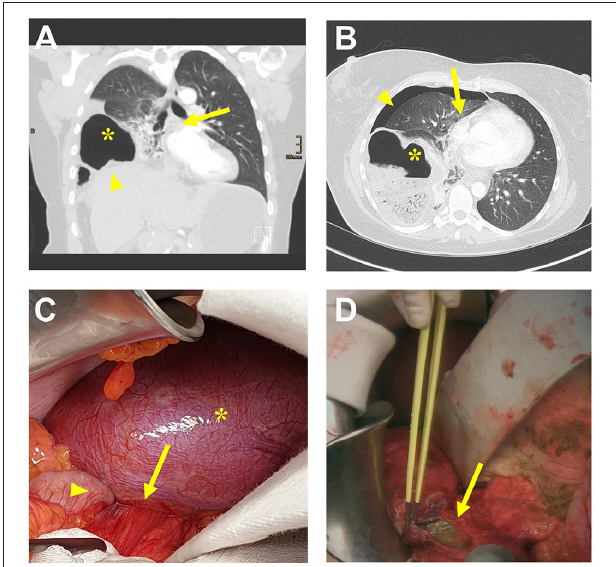
FIGURE 1 | (A) Computed tomography (CT) scan (coronal plane) of the chest and upper abdomen showing elevated right hemi-diaphragm (arrowhead), right-sided diaphragmatic herniation of ascending colon (star), and mediastinal shift to the left side (arrow). (B) CT scan (axial plane) of the chest showing herniated right-sided ascending colon (star), pleural effusion (arrowhead), and mediastinal shift to the left side (arrow). (C) Intra-operative abdominal situs showing the right posterolateral defect (arrow) of the bulged diaphragm (star) with herniation of the ascending colon (arrowhead). (D) Intra-operative situs showing the colon perforation (arrow).